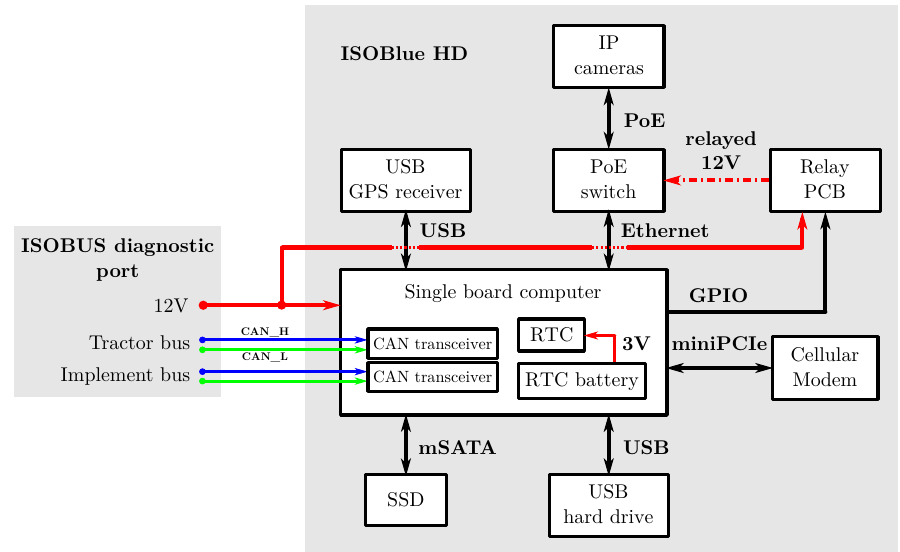
Figure 3. ISOBlue HD connects to a machine’s ISOBUS diagnostic port for both power and CAN bus signals. The single board computer interfaces with various components for data collection, data storage, sensor control, and cellular connectivity.